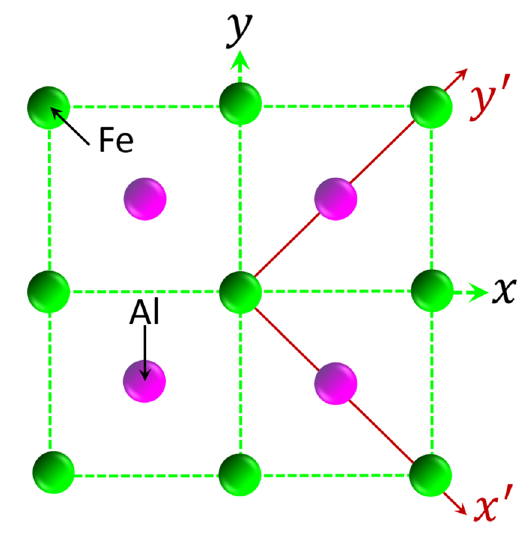
Figure 1. The projection of 2×2 super FeAl cell along <001>